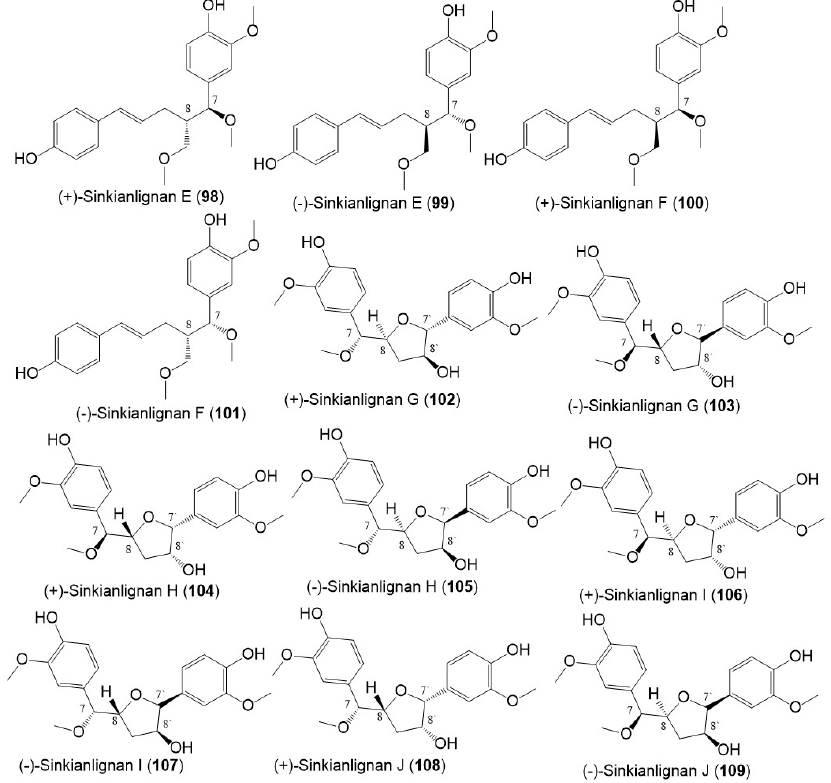
Figure 13. Structures of lignans ( 98 – 109 ) reported from F. sinkiangensis . Sesquilignans are type of lignans that consist of 3 phenylpropanoid units. Compound